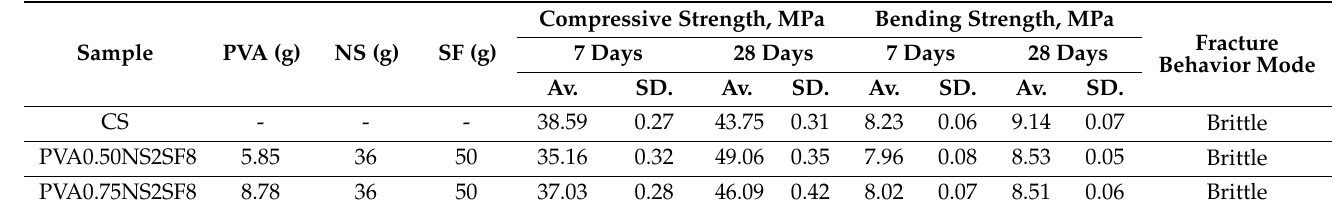
Table 12. Compressive and bending strengths of mortar containing PVA and optimum percentages of NS and